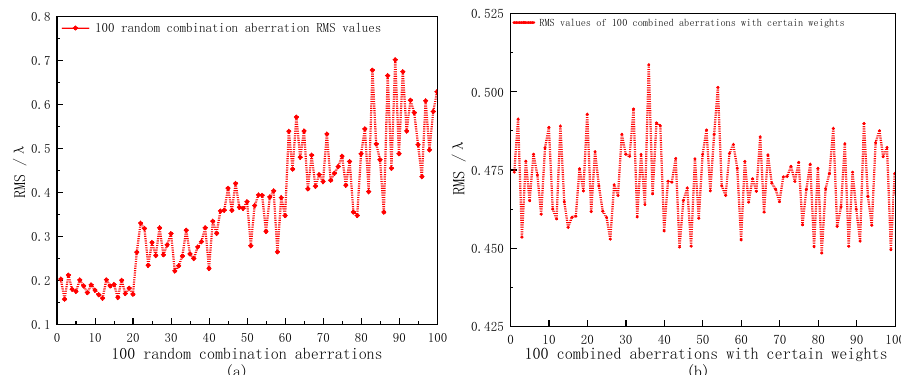
Figure 5. RMS values of 100 combined aberrations: ( a ) random combined aberrations; ( b ) combined aberrations with certain weights.